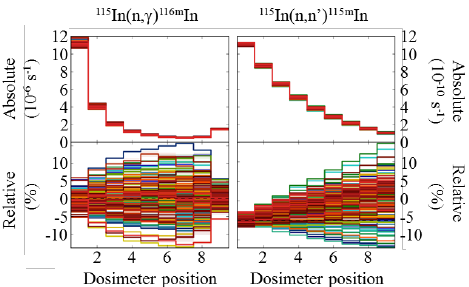
Fig. 3. Distributions of absolute and relative capture (left) and inelastic (right) reaction rates of indium dosimeters with regards to their position in the natural iron reflector. These examples were computed with Serpent2 using TMC-CS and 128 ACE files from TENDL-2017 representative of the iron cross sections.